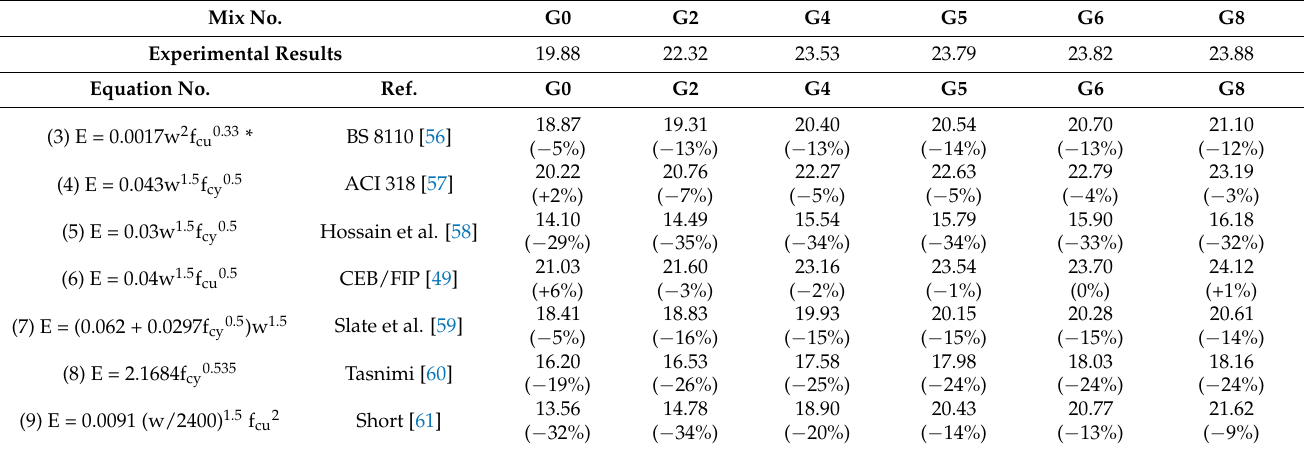
Table 8. The measured 28-day modulus of elasticity and the predicted modulus of elasticity from the equations (MPa).